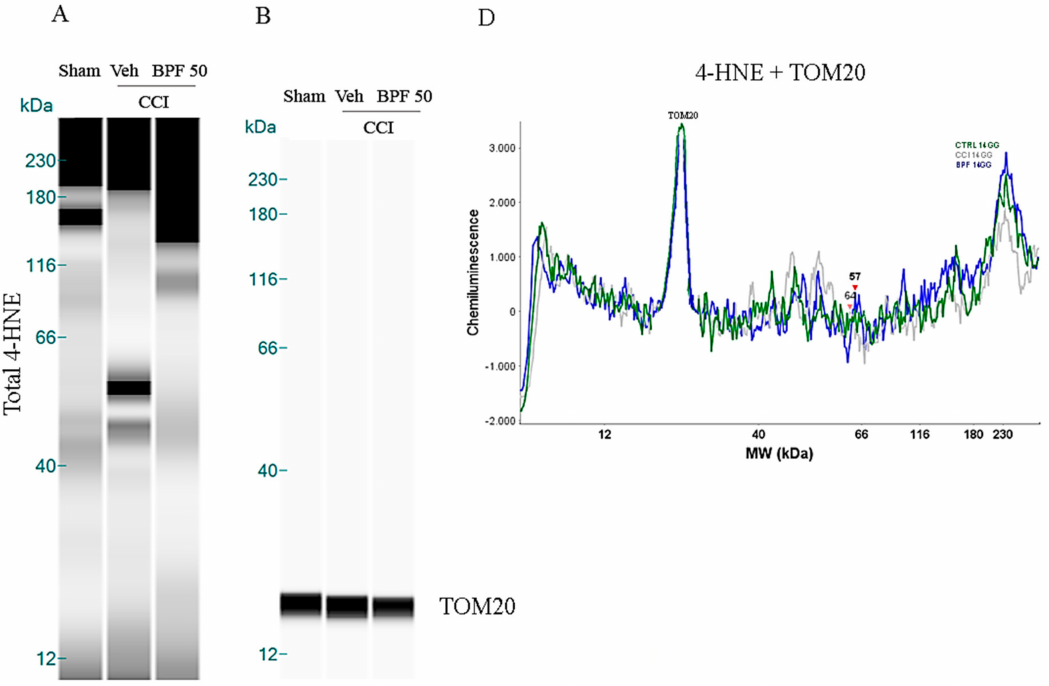
Figure 2. Malondialdehyde is associated with an increase of oxidative stress during neuropathic pain. Spinal malondialdehyde (MDA)indicates the presence of oxidative stress during chronic pain either 14 days ( A ) and 21 days ( B ) post injury. CCI rats showed a significant level of MDA either 14- and 21-days post injury. Subcutaneous infusion of BPF (50 mg / kg), concurrently with surgery (day 0), led to a significant reduction of these values. Results are expressed as mean ± SEM for 6 rats. * p < 0.05 compared to sham; † p < 0.05 compared to vehicle + CCI.